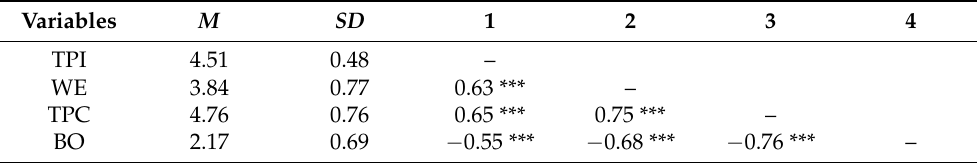
Table 1. Means standard deviations, and bivariate correlations among variables.